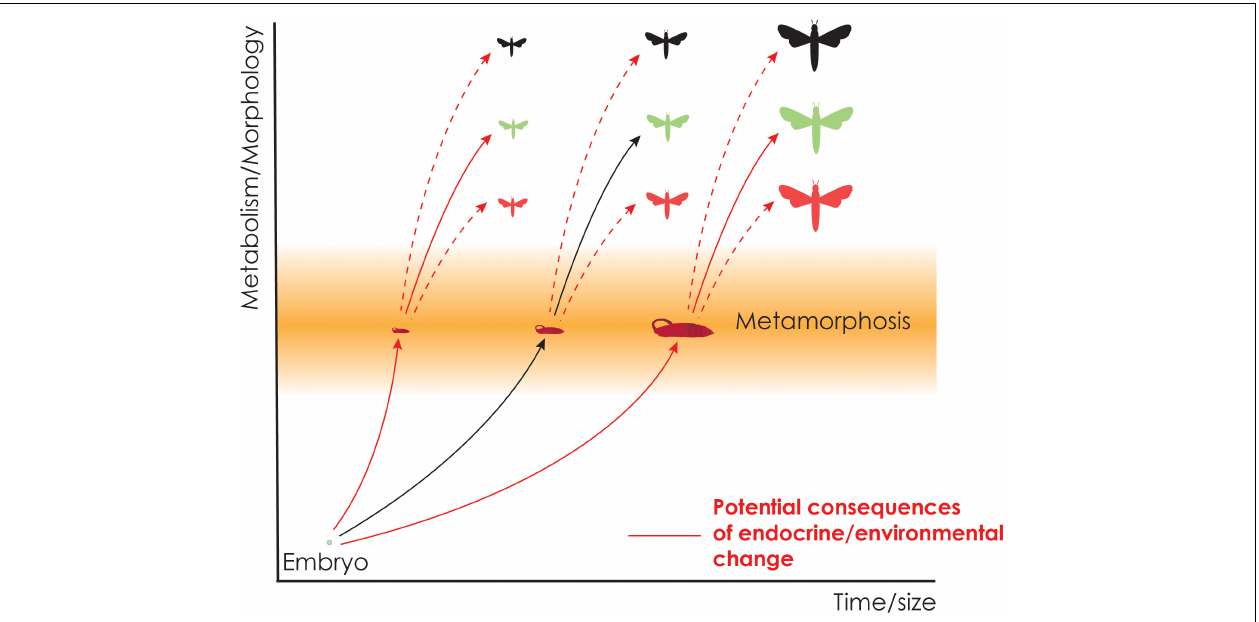
FIGURE 3 | Potential consequences of environmental changes on the timing of metamorphosis and the development of adult phenotypes during metamorphosis. Adult body size can become larger or smaller through changes in the timing of metamorphosis (solid red lines), or distinct morphologies may develop in response to environmental changes (dotted red lines). These events are often regulated by endocrine processes that respond to environmental